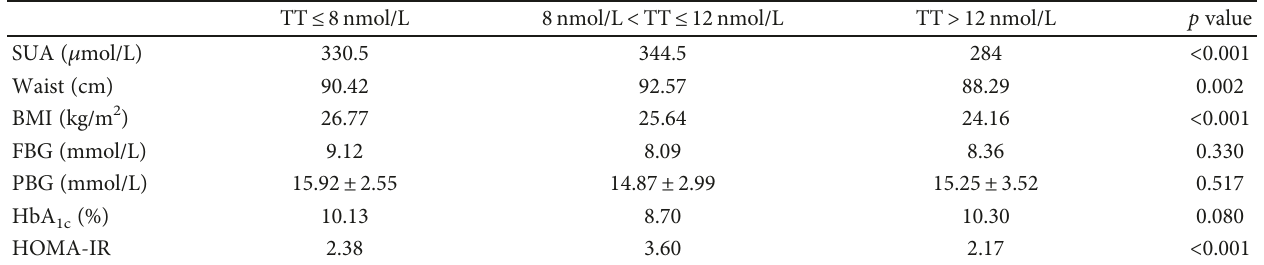
Table 3: Comparison of di ff erent TT groups ( x ± s /median ).